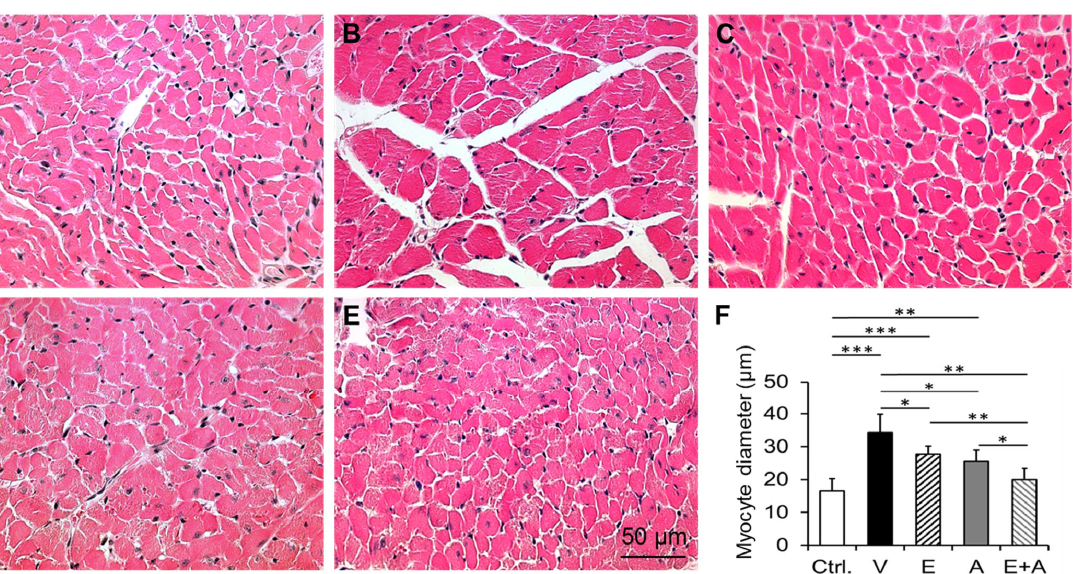
Figure 8. Changes in cardiac 8OHdG+ in diabetic ALDH2*2 mutant mice exhibiting HFpEF with vehicle, EMP, Alda-1 and EMP + Alda-1 treatments. Representative micrographs of 8OHdG immunostained sections from control ( A ), vehicle-treated ALDH2*2 mutant diabetic mice ( B ), EMP-treated ALDH2*2 mutant diabetic mice ( C ), Alda-1 treated ALDH2*2 mutant diabetic mice ( D ) and EMP and Alda-1 combinedly treated ALDH2*2 mutant diabetic mice ( E ). Blank (negative control) was shown in ( F ). The quantification of 8OHdG+ in cardiac tissue was shown ( G ). Data are presented as mean ± standard error of the mean (SEM). n = 4. ** p < 0.01 and *** p < 0.001 refer to the difference between individual groups as shown.